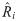
Number of daily new cases and the reproduction number R^i estimated using the state-space method.Italy, Japan, Saudi Arabia, and the USA.